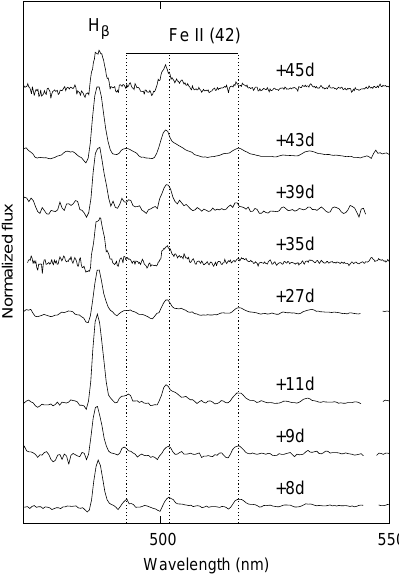
Figure 3: The spectra of V5587 Sgr in early phase.